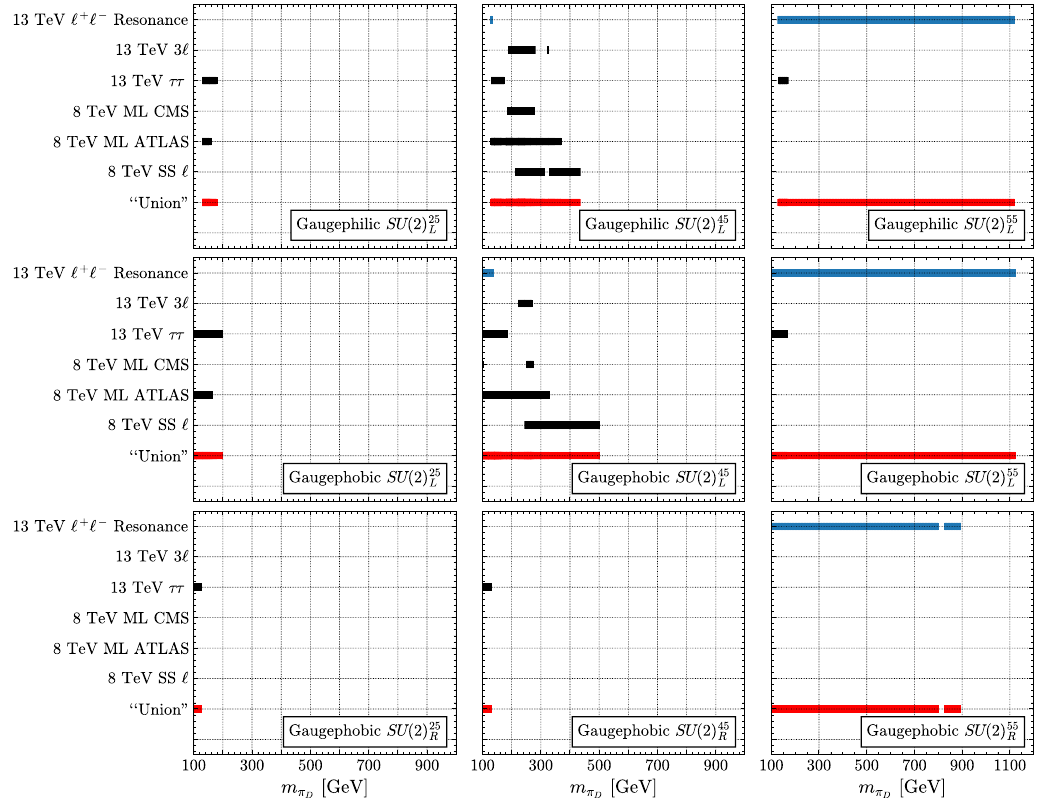
Figure 6 . Summary of the dark meson exclusions for the benchmark scenarios and values of the π D and ρ D masses. The scenarios are labeled by the type of kinetic mixing, the ratio of the dark , and the relative strength of the fermionic versus bosonic pion to dark rho mass η = m π D /m ρ D dark pion decay modes. All of the dark pions decay promptly. The top line indicates the bound on inferred from recasting the latest dilepton bounds and interpreted in terms of m ρ 0 D mass bound from the most constraining 8 and 13 TeV searches we five lines (in black) show the π D could find. The union of the exclusions from all of the searches is shown in the last